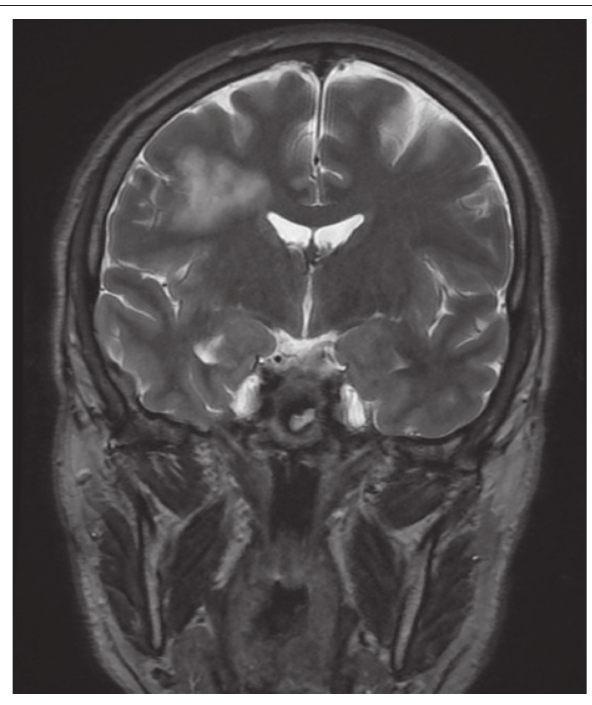
FIGURE 3: Coronal T2-weighted MR